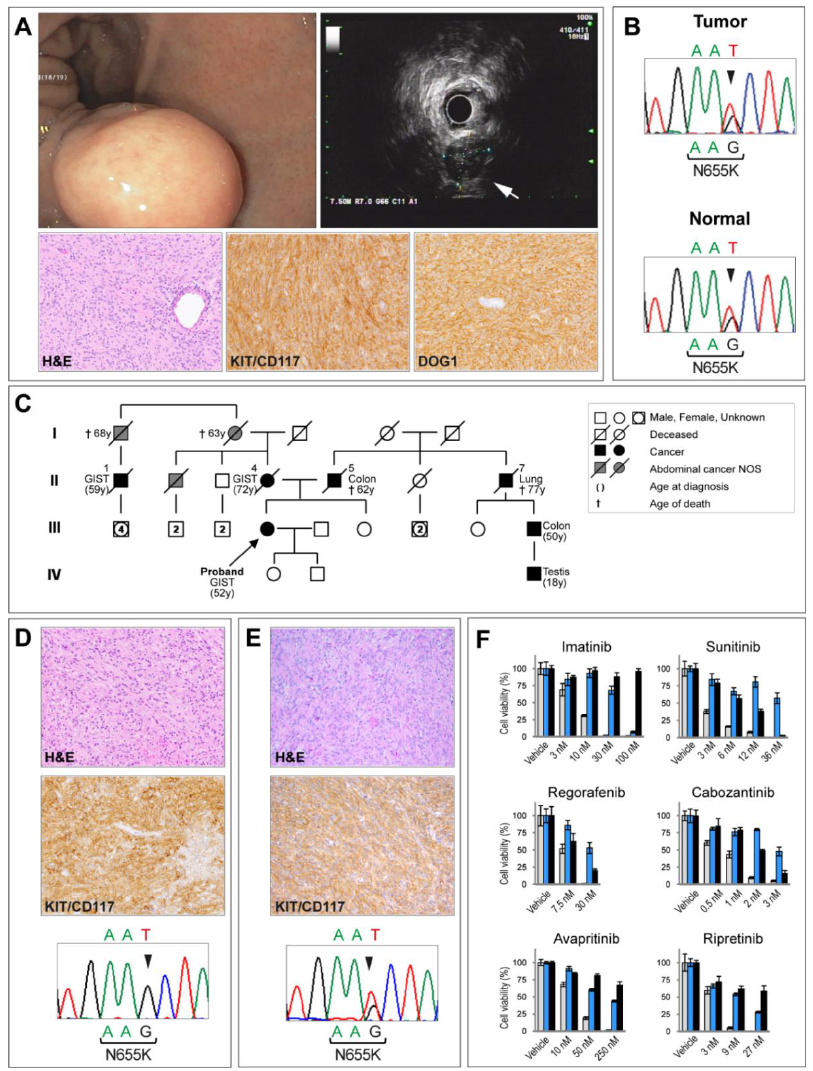
Figure 1. ( A ) Index case: endoscopic and histopathologic characteristics. Endoscopic (upper panel, left) and endoscopic ultrasound (upper panel, right) appearance of the submucosal gastric tumor of the index case (arrow). Lower panels: hematoxylin and eosin (H&E) staining of the lesion revealed bundles of spindle cells arranged in fascicles. Tumor cells displayed positive immunoreactivity for KIT /